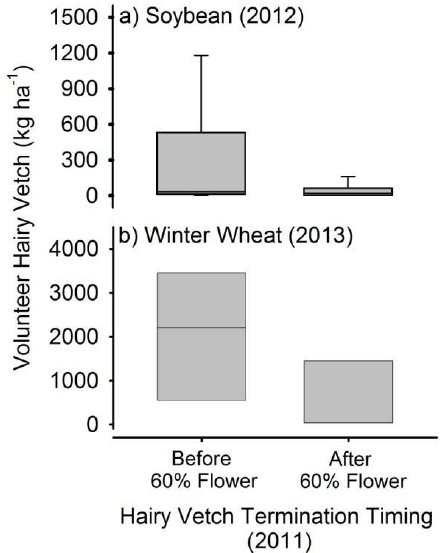
Figure 6. Effect of hairy vetch termination timing in 2011 on volunteer hairy vetch abundance in the following soybean (2012) and winter wheat (2013) cash crops averaged across Pennsylvania and Maryland locations (data from the ROSE). Hairy vetch termination ranged from the vegetative stage to 100% flowering on the last five nodes below the apical